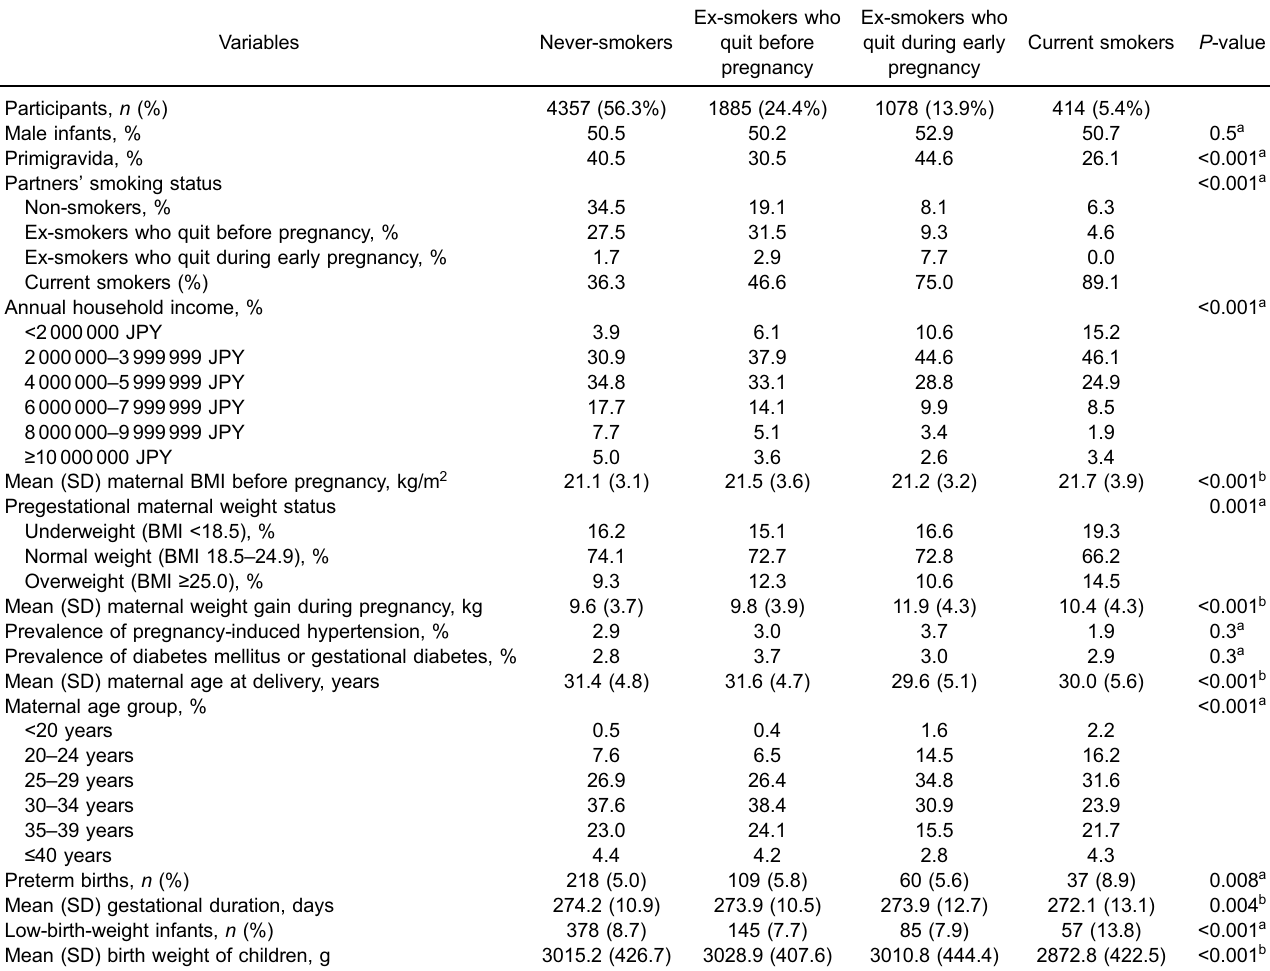
Table 1. Characteristics of participants by smoking status during pregnancy